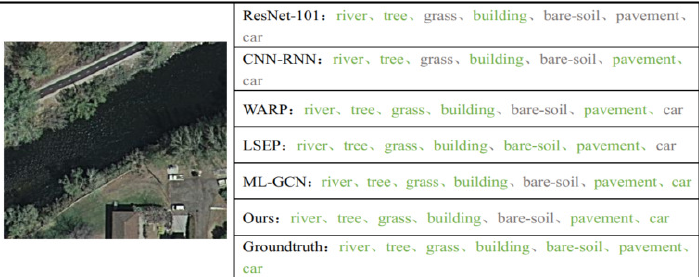
Figure 19. Qualitative results. Example